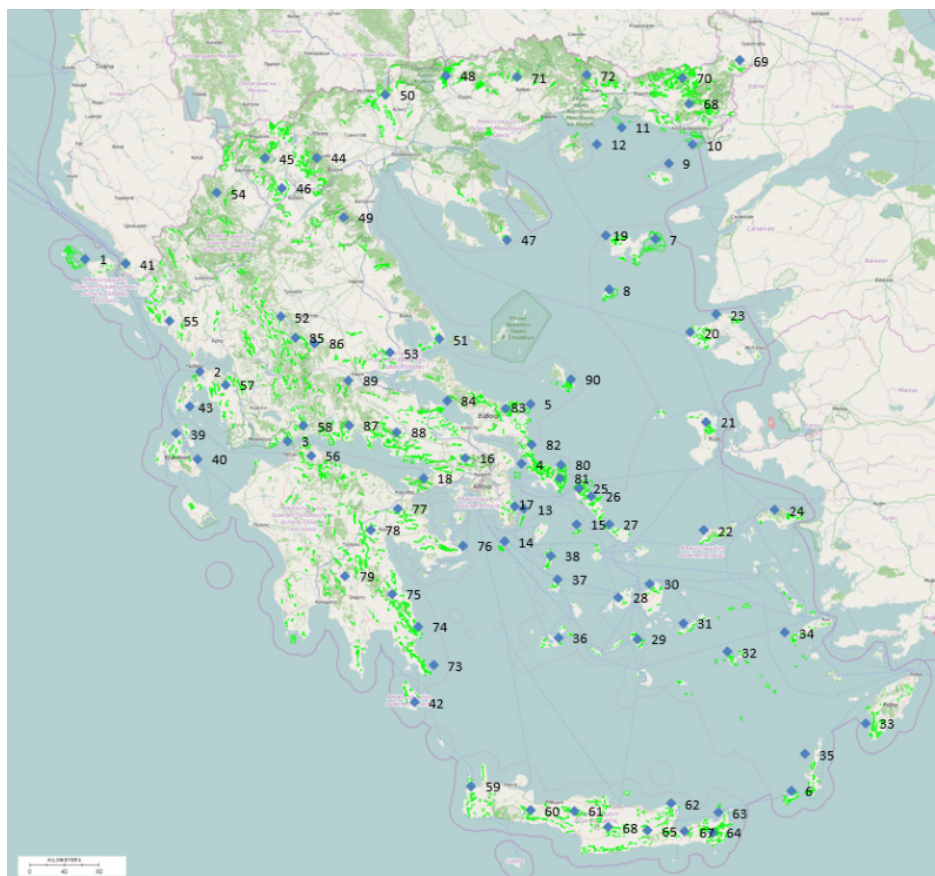
Figure 3. Overview of wind farms applications in the Greek territory and selection of representative points in the whole Greek territory.